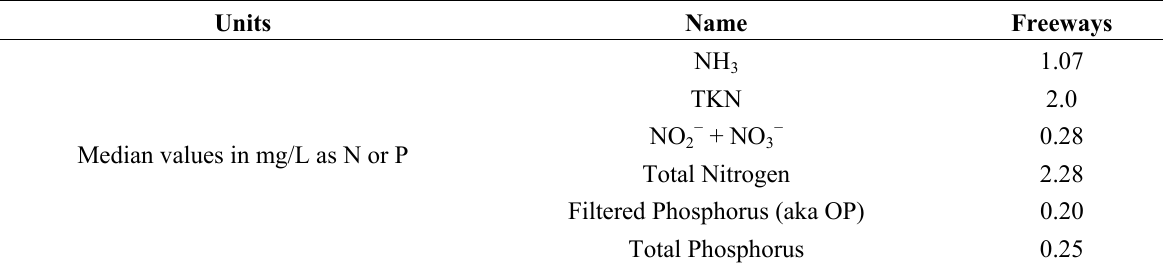
Table 1. National Stormwater Quality Database average nitrogen and phosphorus species concentrations for freeway runoff